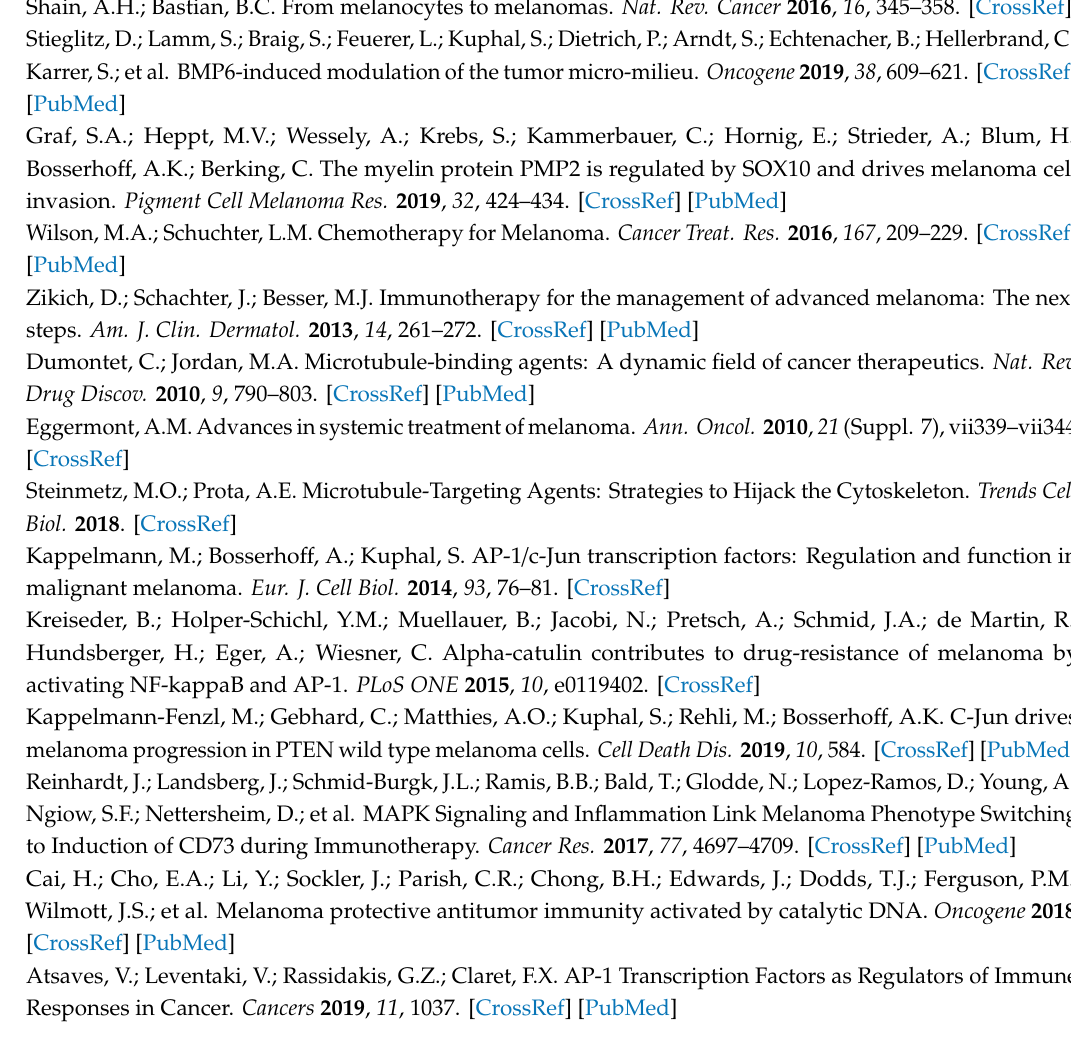
Figure S1: Microtubule targeting drugs (MTDs) influence AP-1 activity and AP-1 DNA-binding activity, Figure S2: Co-sedimentation by ultra-centrifugal spin-down assays show no binding between c-Jun and polymerized microtubules, Figure S3: Determination of the input protein amounts used for immunoprecipitation (experiments shown in Figure 2a,b and Figure 3d–h), Figure S4: Determination of TUB1A-suppression e ffi ciency by qRT-PCR and Western blot analysis, Figure S5: α -Tubulin knockdown resulted in a reduced AP-1 activity in a stable AP-1 LUC clone, Figure S6: c-Jun, but not TUB1A, is involved in the AP-1-DNA binding complex, Figure S7: Determination of Importin si-RNA transfection e ffi ciency by qRT-PCR and Western blot analysis, Figure S8: Control immunoprecipitations